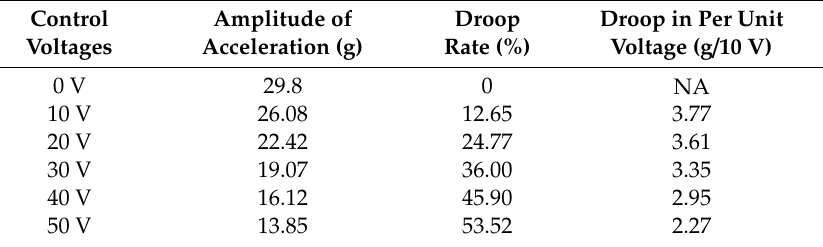
Table 5. Amplitude of acceleration response under di ff erent control voltages.